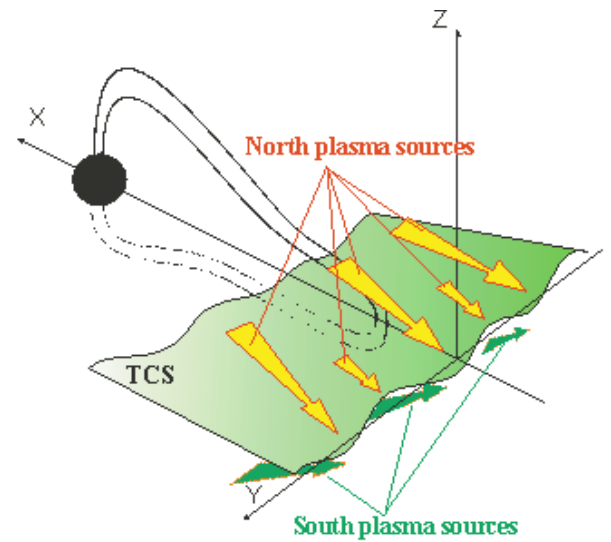
Fig. 41. Schematic of a mechanism of kink-like bending of the current sheet plane due to asymmetry of plasma sources in